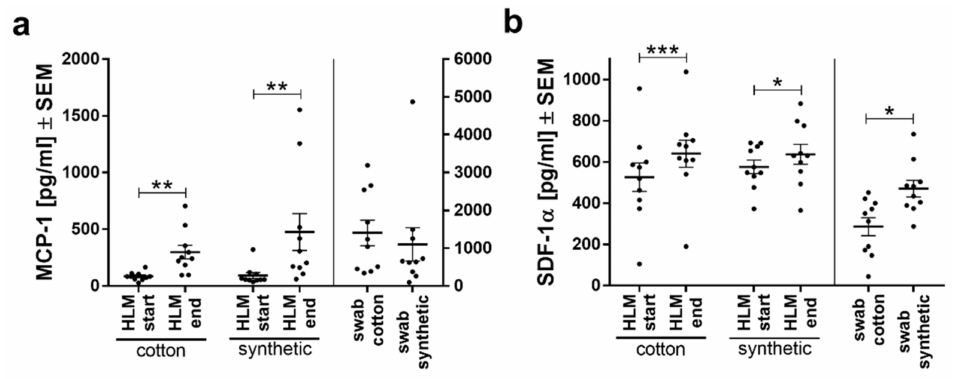
Figure 5. Plasma levels of chemokines are increased during HLM. Shown are plasma levels of ( a ) MCP-1 and ( b ) SDF-1 α as means ± SEM per study group. Differences are measured with Student’s t -test. * p < 0.05, ** p < 0.01, *** p <